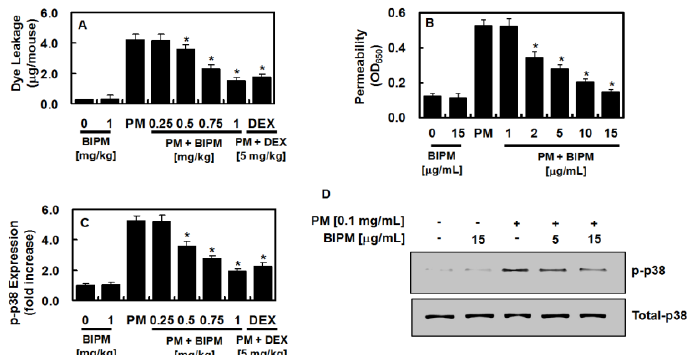
Figure 4. E ff ects of BIPM on PM 2.5 -induced barrier-disruptive responses and p38 mitogen-activated protein kinase (MAPK) activation. ( A , C , D ) The BIPM and DEX groups were injected intravenously 30 min after being intratracheally challenged with PM 2.5 (10 mg / kg in 50 µ L of saline). The e ff ects of BIPM or DEX on PM 2.5 -induced vascular permeability were examined by ( A ) measuring the flux of Evans blue in the BALF (expressed as µ g / mouse, n = 5), ( C ) measuring phospho-p38 expression in purified MLMVECs isolated from each mouse using ELISA, or ( D ) Western blotting. ( B ) The e ff ects of various concentrations of BIPM on PM 2.5 (0.1 mg / mL, 6 h)-induced barrier disruption were monitored as the flux of Evans blue-bound albumin across MLMVECs. * p < 0.01 versus the PM-challenged group.